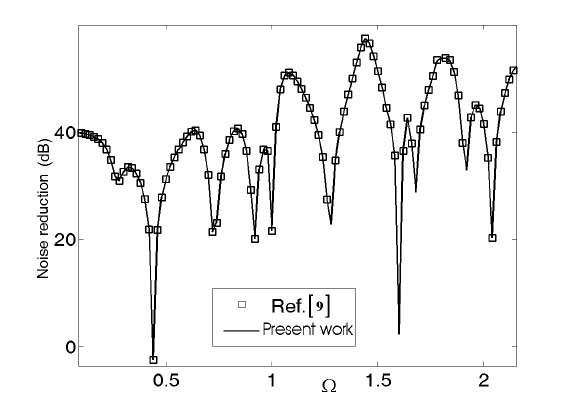
Fig. 2. Comparison of the noise reduction obtained from Ref. [9] with those obtained from the present work for the case of monostatic back scattering of the steel cylinder.